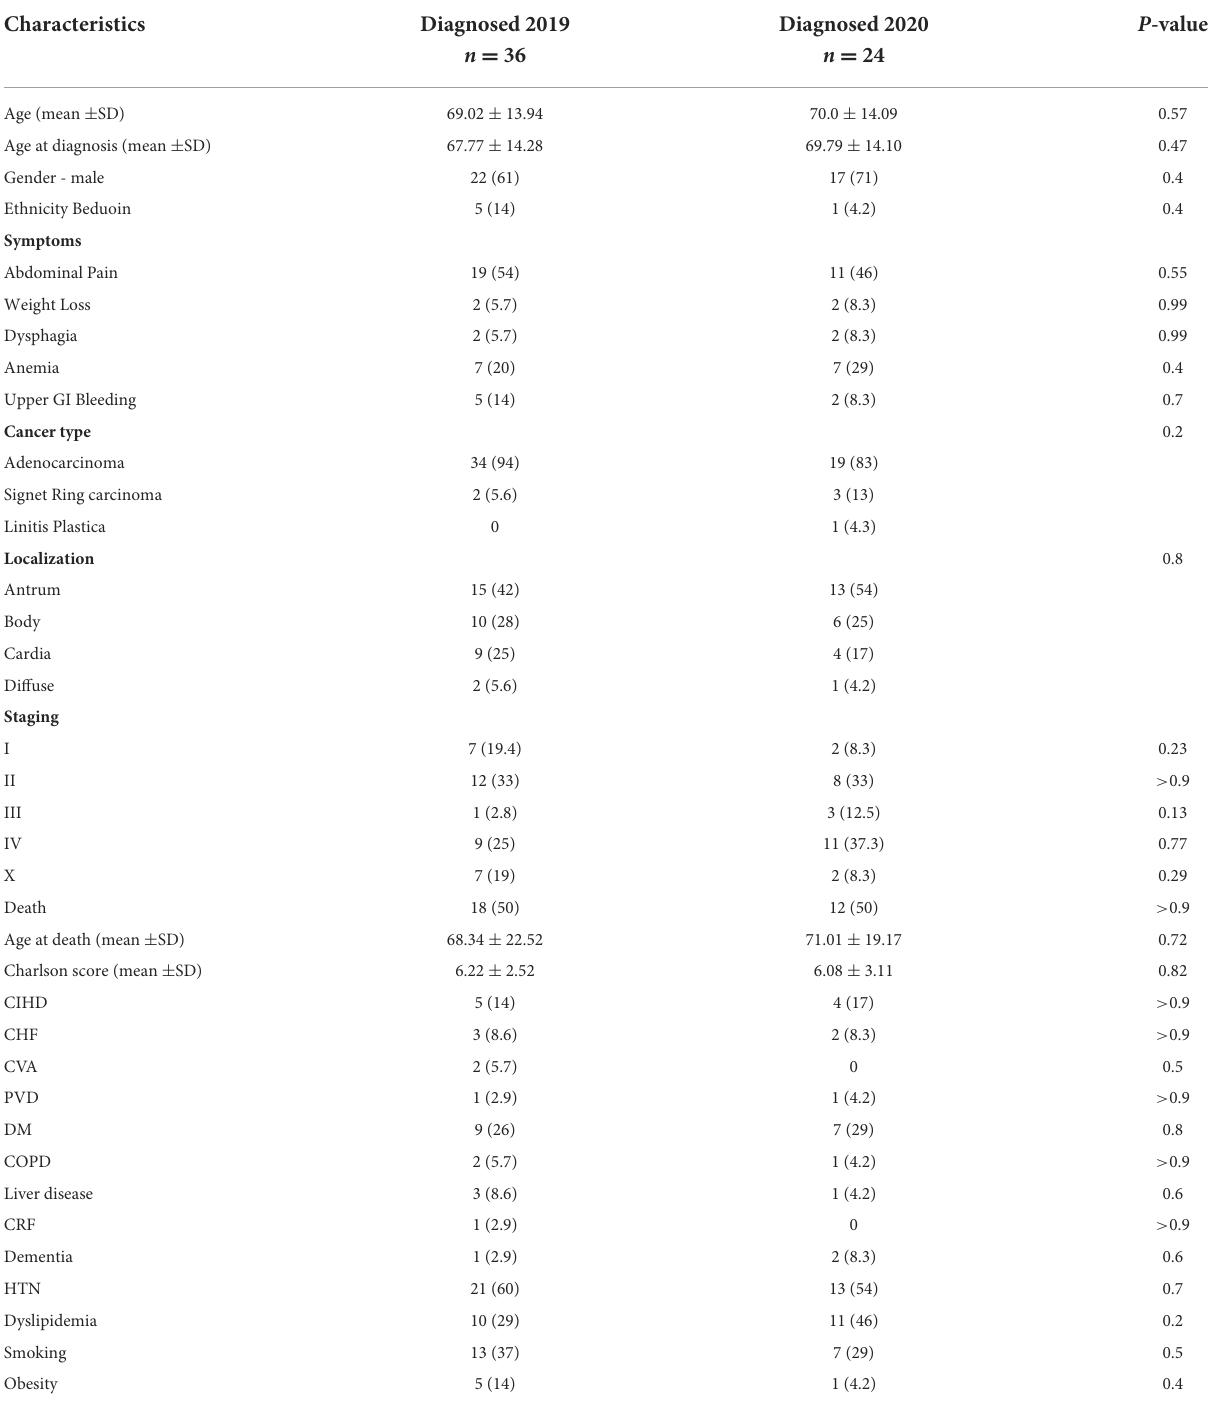
TABLE 2 Demographic and clinical characteristics of patients with gastric cancer in the years 2019 and 2020.